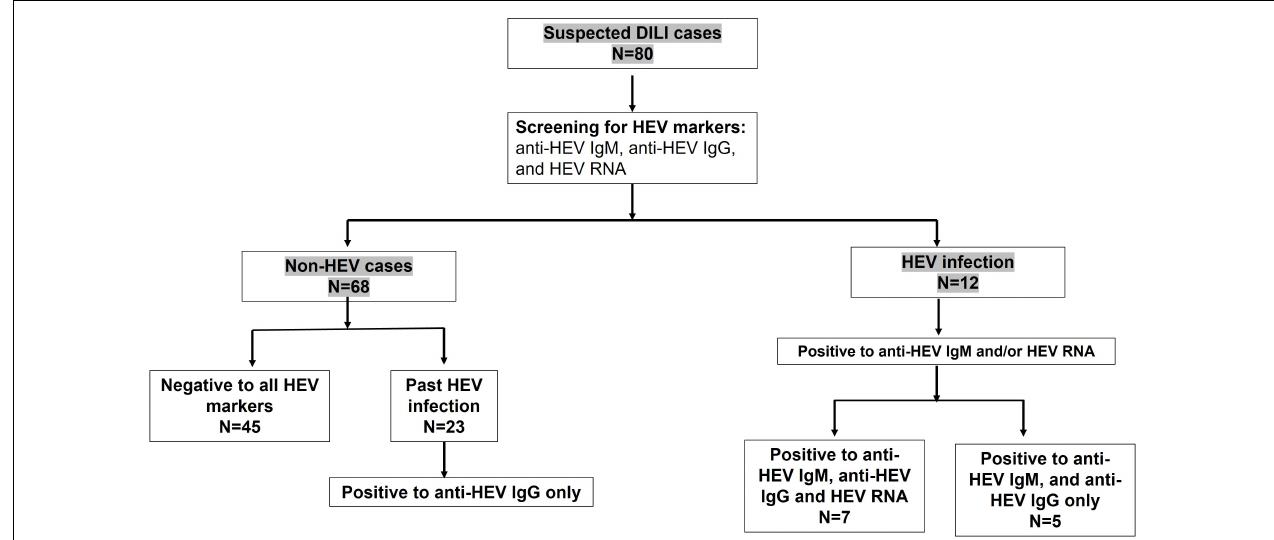
FIGURE 2 | Assessment of hepatitis E virus (HEV) markers in suspected drug-induced liver injury (DILI). Suspected DILI samples ( n = 80) were reassessed for HEV markers, such as anti-HEV IgM, HEV RNA, and anti-HEV IgG. Twelves samples were positive to anti-HEV IgM and anti-HEV IgG, from which seven samples were also positive to HEV RNA. Forty-five ( n = 45) samples were negative to all HEV markers, and 23 samples were positive only to anti-HEV IgG, indicating a past